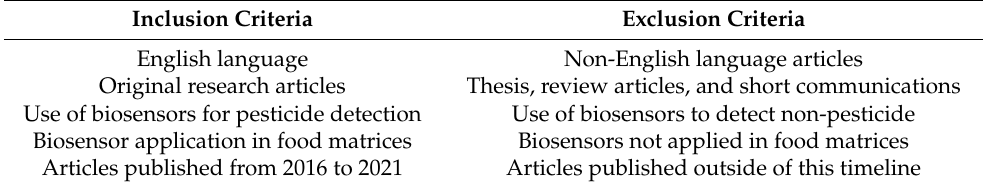
Table 1. Inclusion and exclusion criteria used for the selection of articles. Inclusion